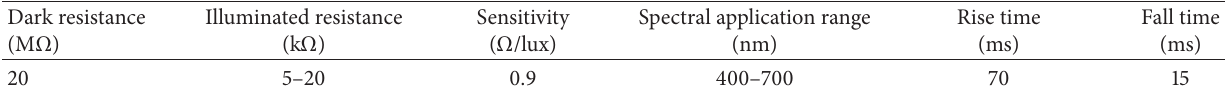
Table 1: Specification of LDR.